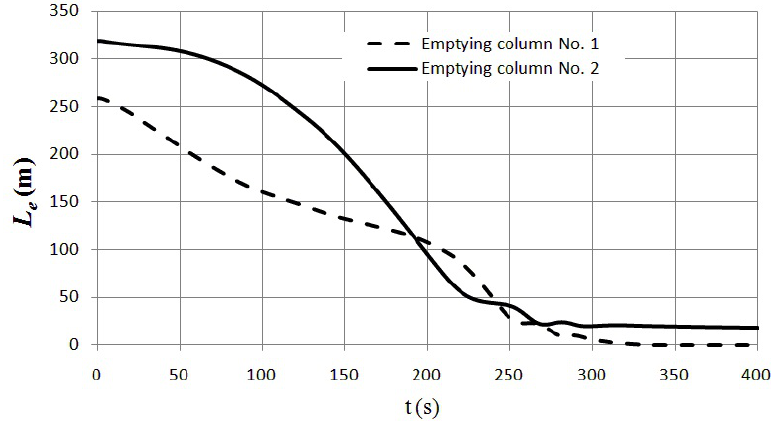
Figure 6. Evolution during the hydraulic event of the length of the emptying columns.